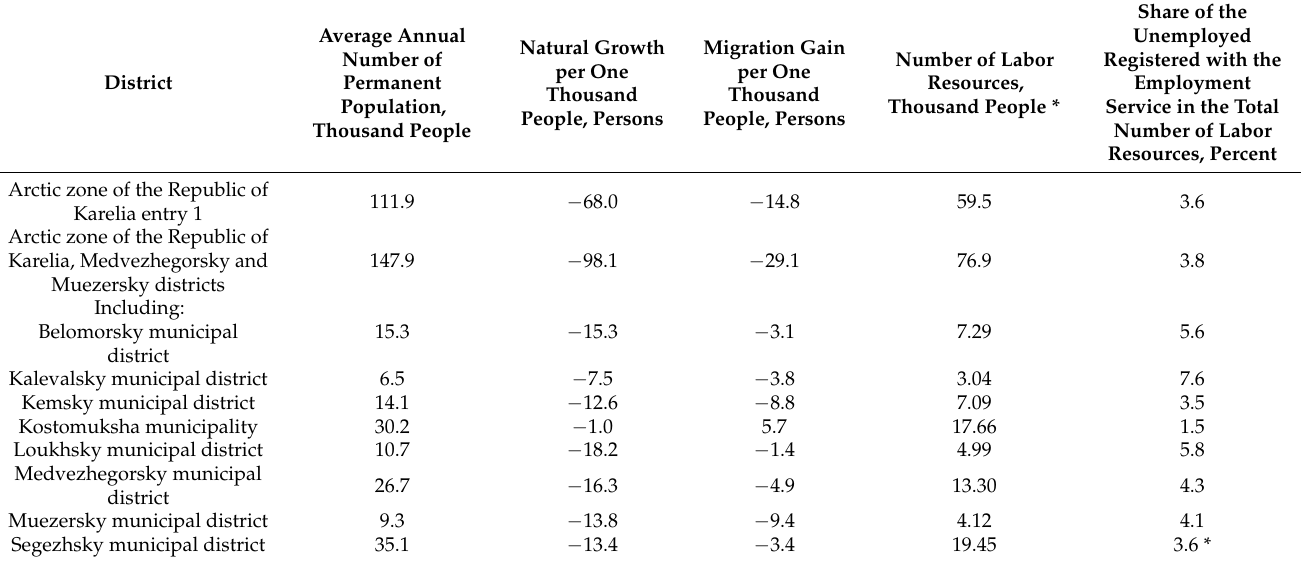
Table 2. Indicators of socio-economic development of Karelian Arctic districts in